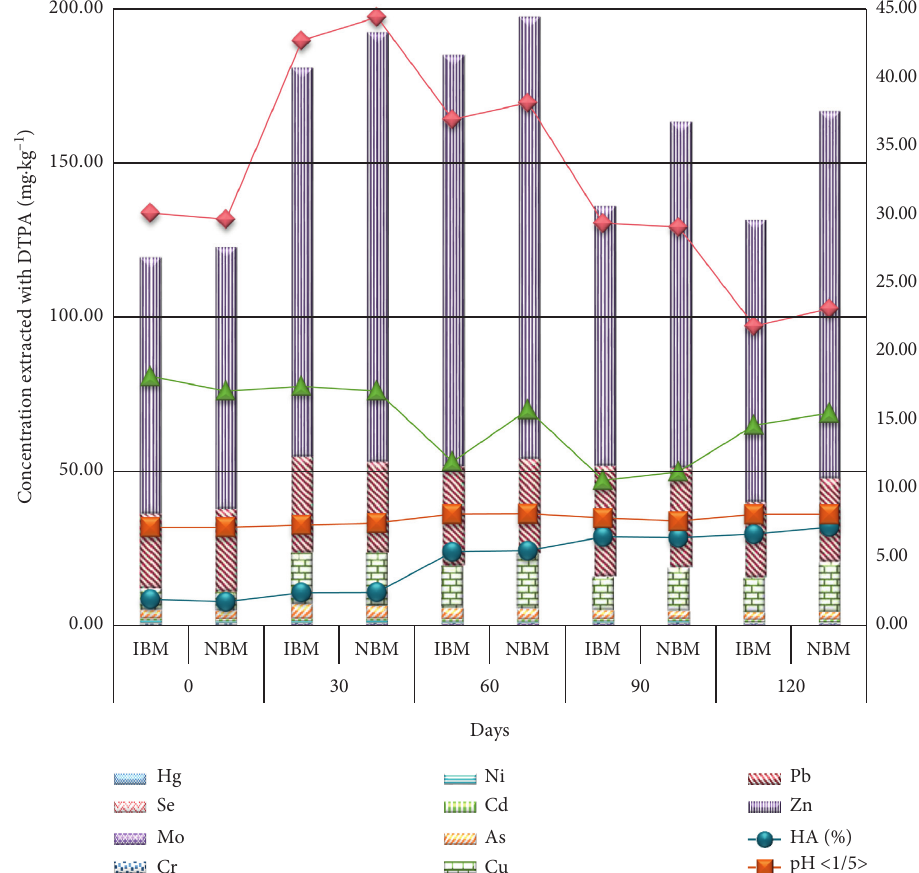
Figure 8: Concentration of heavy metals and trace elements of interest extracted with DTPA and physicochemical variables (HA, pH, temperature, and C/N ratio) during the composting of cow manure and tree litter in piles inoculated with beneficial microorganisms (IBMs) and in noninoculated (NBM)